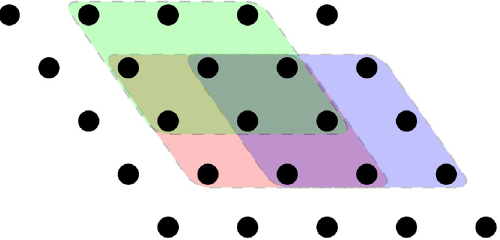
FIG. 1. Different support of the density matrices, enclosed in three different dashed regions, colored in red, blue, and green in a counterclockwise direction. (The overlaps of the supports are colored with their respective color mixtures.) Each subsystem contains 3 × 3 ¼ 9 local degrees of freedom, denoted by the black dots. The supports of the density matrices may overlap with each other, as shown in this example.